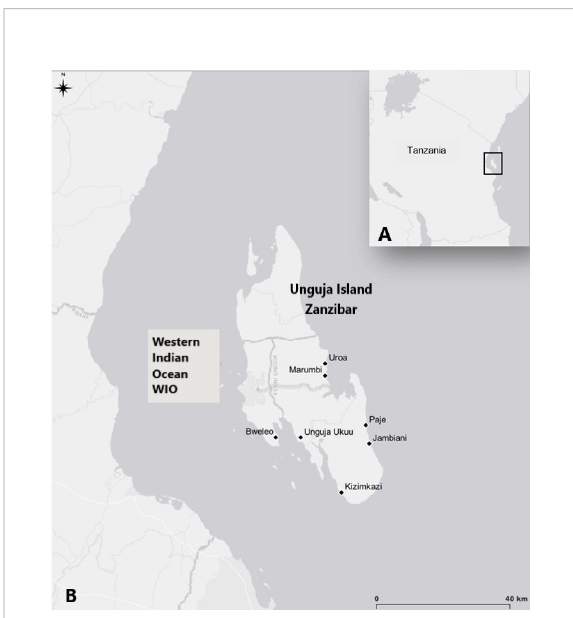
FIGURE 2 Zanzibar (Unguja Island), Tanzania. (A) Zanzibar ’ s position in relation to Tanzania. (B) Zanzibar map showing the research sites. The black dots represent the villages where the interviews were conducted with coastal women (N=117) to investigate their adaptive capacity to climate